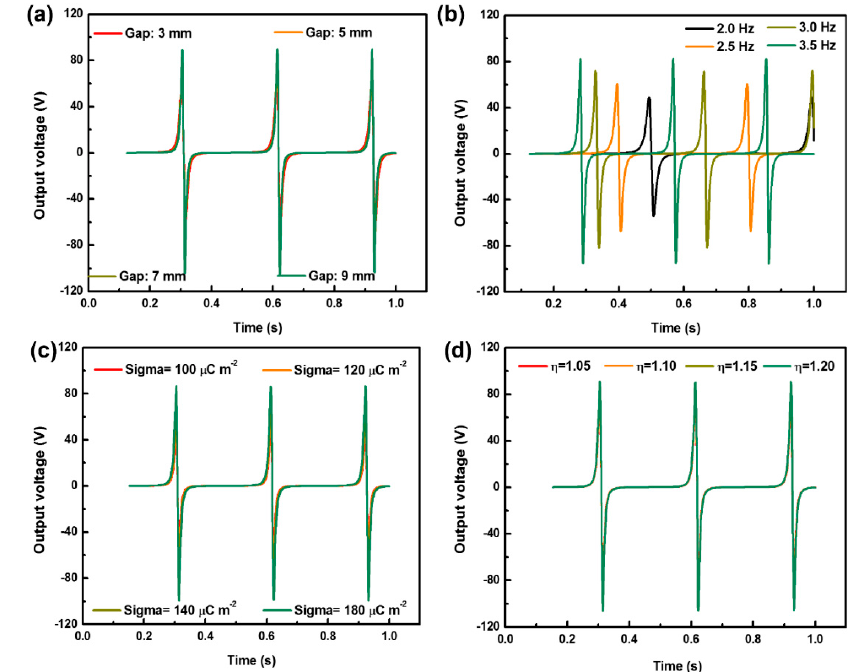
Figure 11. Influences of gap ( a ), frequency ( b ), surface charge ( c ) and effective surface factor ( d ) on output voltage behaviors.